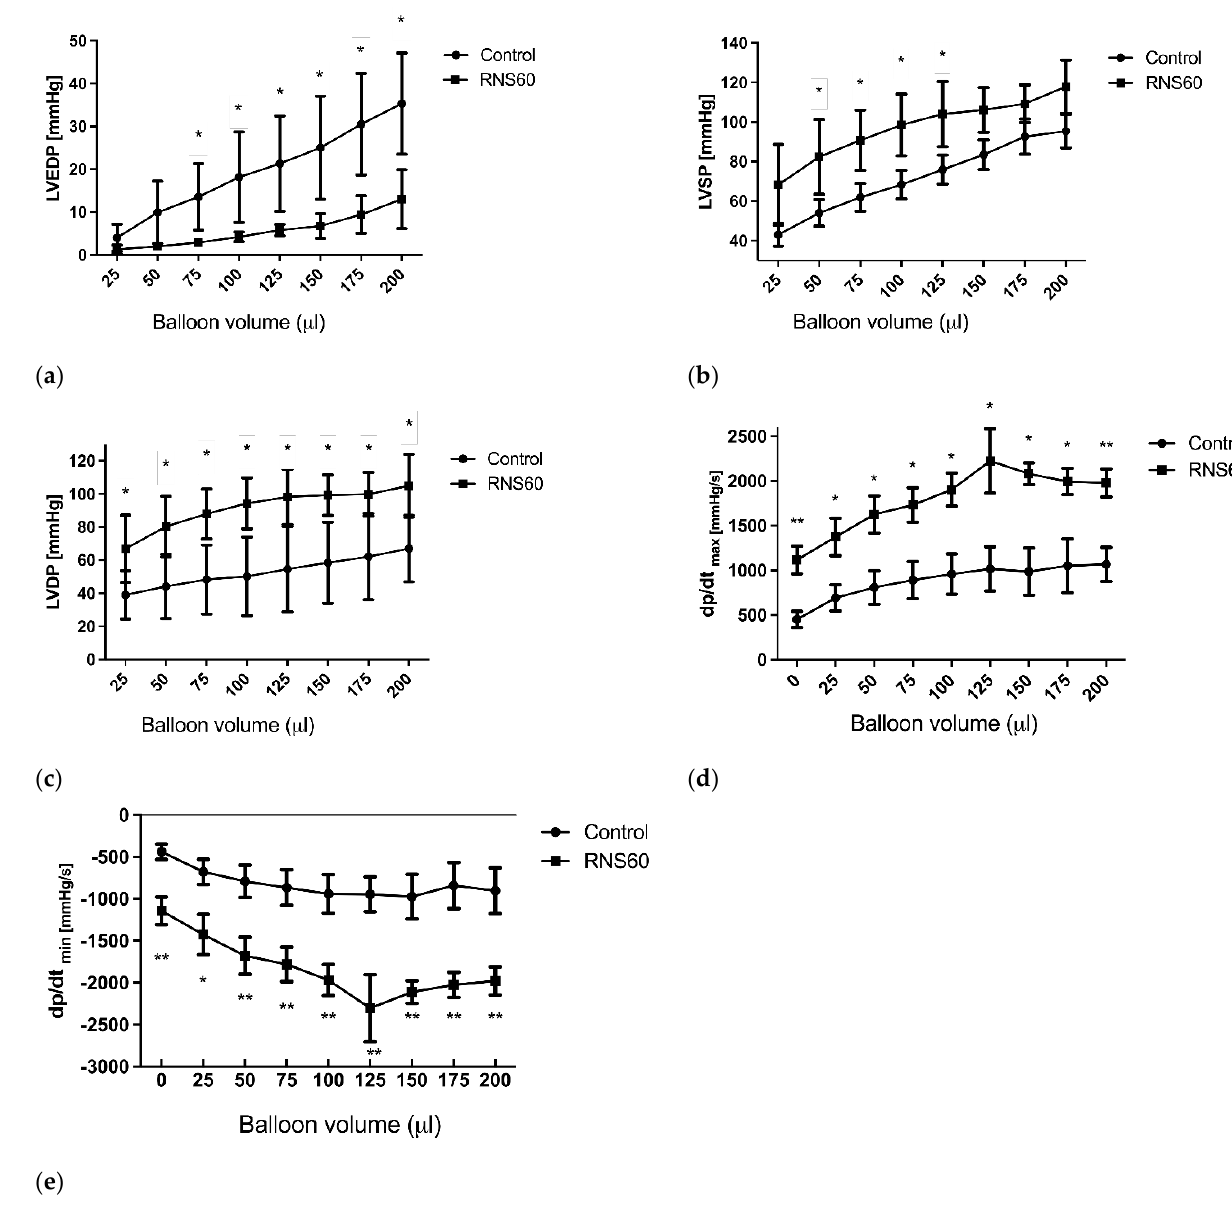
Figure 2. Changes in biomarkers of hypoxia. ( a ) Serum troponin T concentration, ( b ) serum creatine kinase activity in ApoE −/− LDLr −/− mice that received intravenous injection of RNS60 or saline as con- trol 5 h after the hypoxic event. Values represent mean ± SEM (n = 5); * p < 0.02, ** p < 0.006.